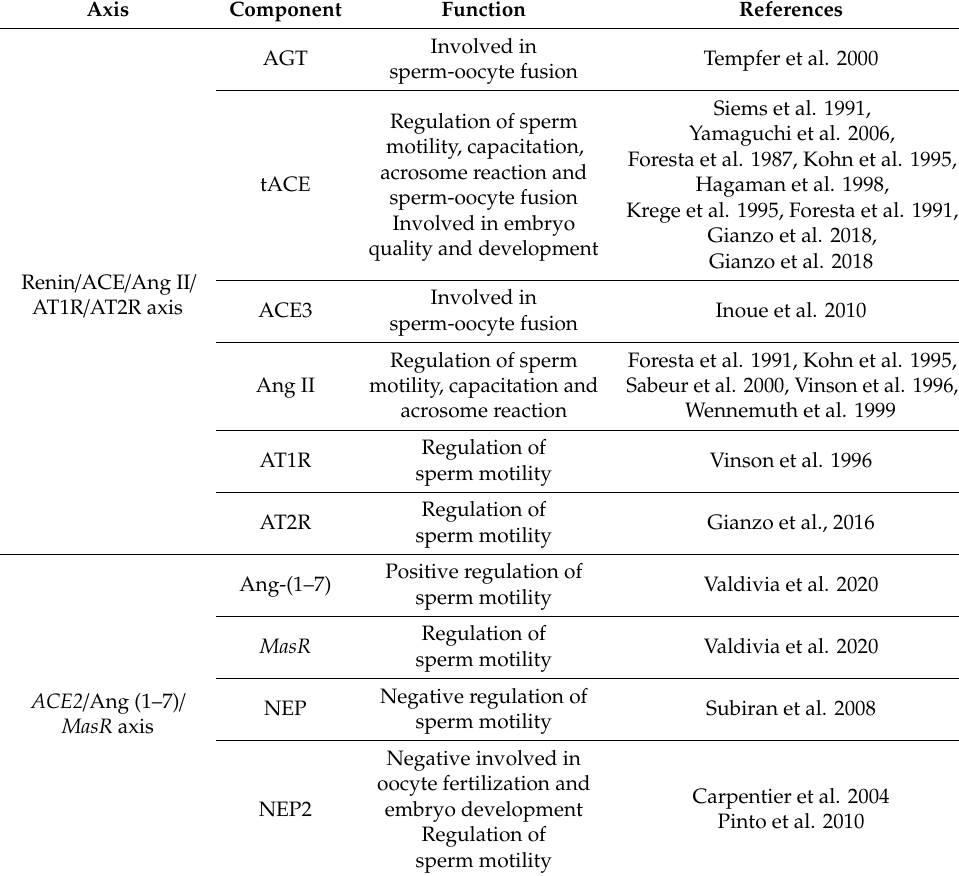
Table 2. Regulation of the sperm physiology by local